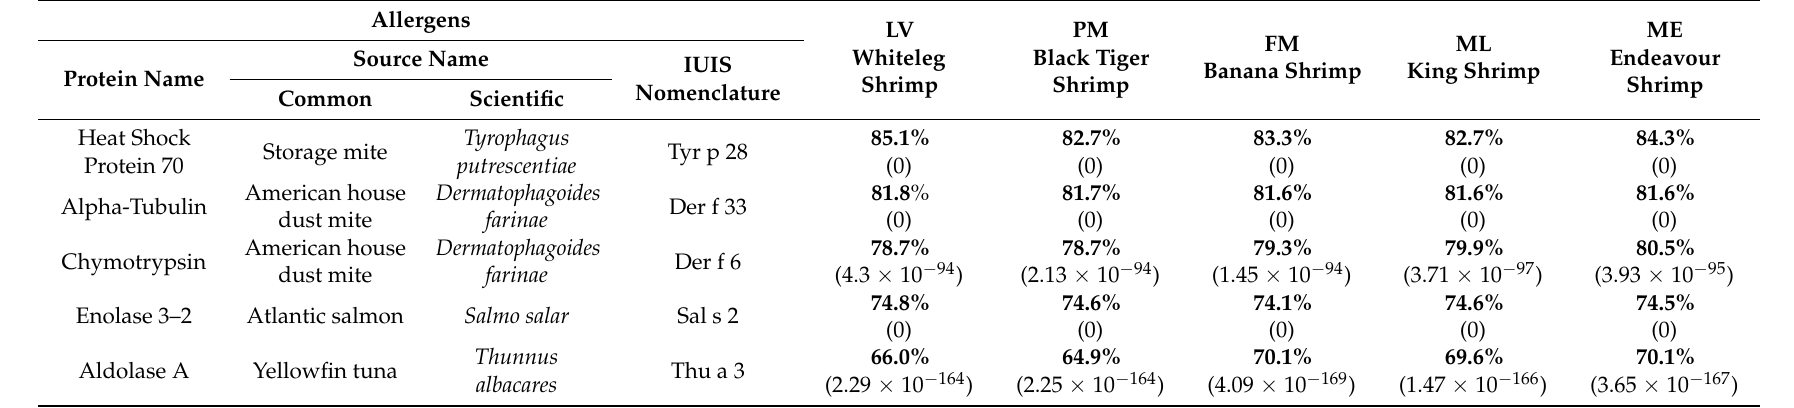
Table 2. List of unreported potential allergens identified that have a minimum of 70% pairwise identity value in at least one species. List includes protein name, the common and scientific name of the allergen source, along with the allergen’s IUIS nomenclature, % Pairwise identity, and E-values. % Pairwise identity values are in bold and E-values are in brackets. LV: L. vannamei , PM: P. monodon , FM: F. merguiensis , ML: M. latisulcatus , ME: M. endeavouri